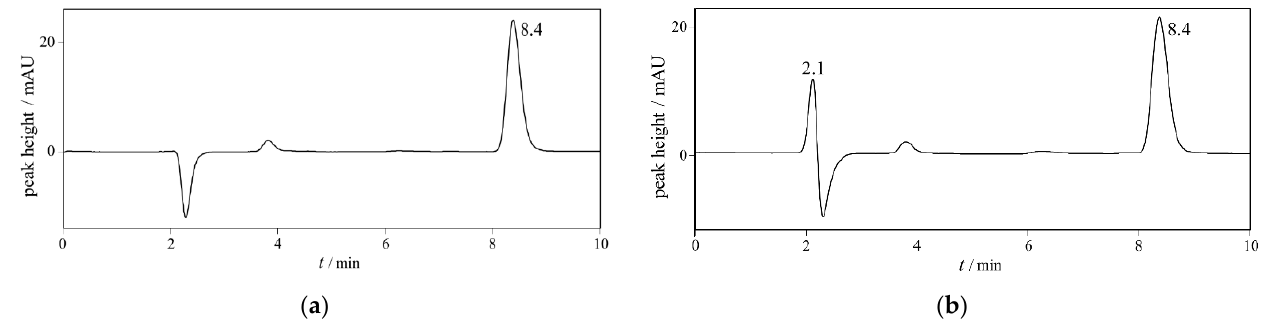
Figure 2. HPLC chromatograms of ( a ) caprylic acid and ( b ) QC samples (IVIG sample spiked with CA) after precipitation of IgGs by ACN. Chromatographic conditions are given in Table 1.